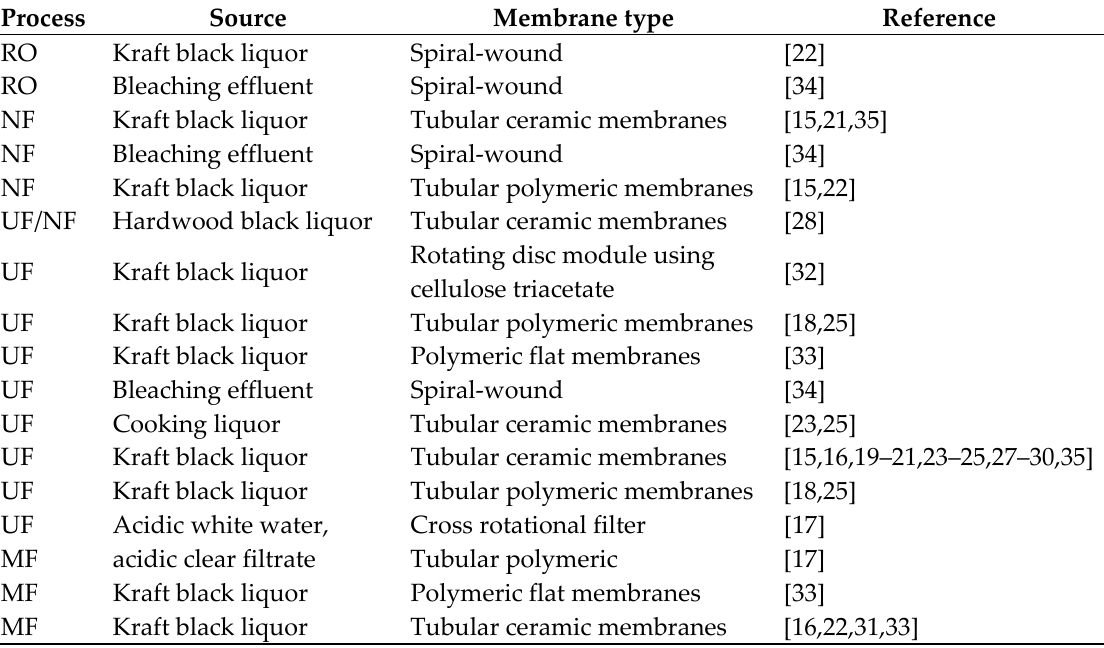
Table 1. Overview of recent studies investigating membrane technologies for the treatment of wastewater from pulp and paper